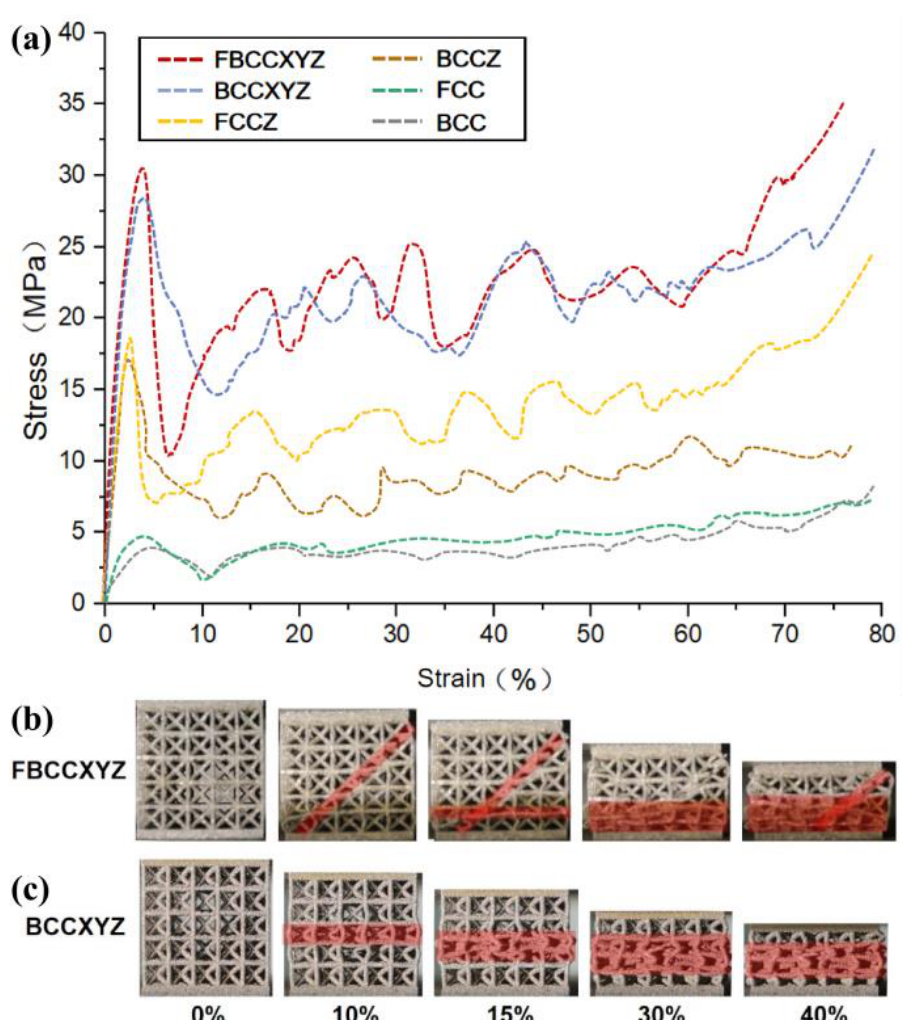
Figure 11. Compressive stress–strain curves of several lattice structures with different geometric configurations ( a ), deformation morphologies of FBCCXYZ ( b ), and BCCXYZ ( c ) lattice specimens during compression.